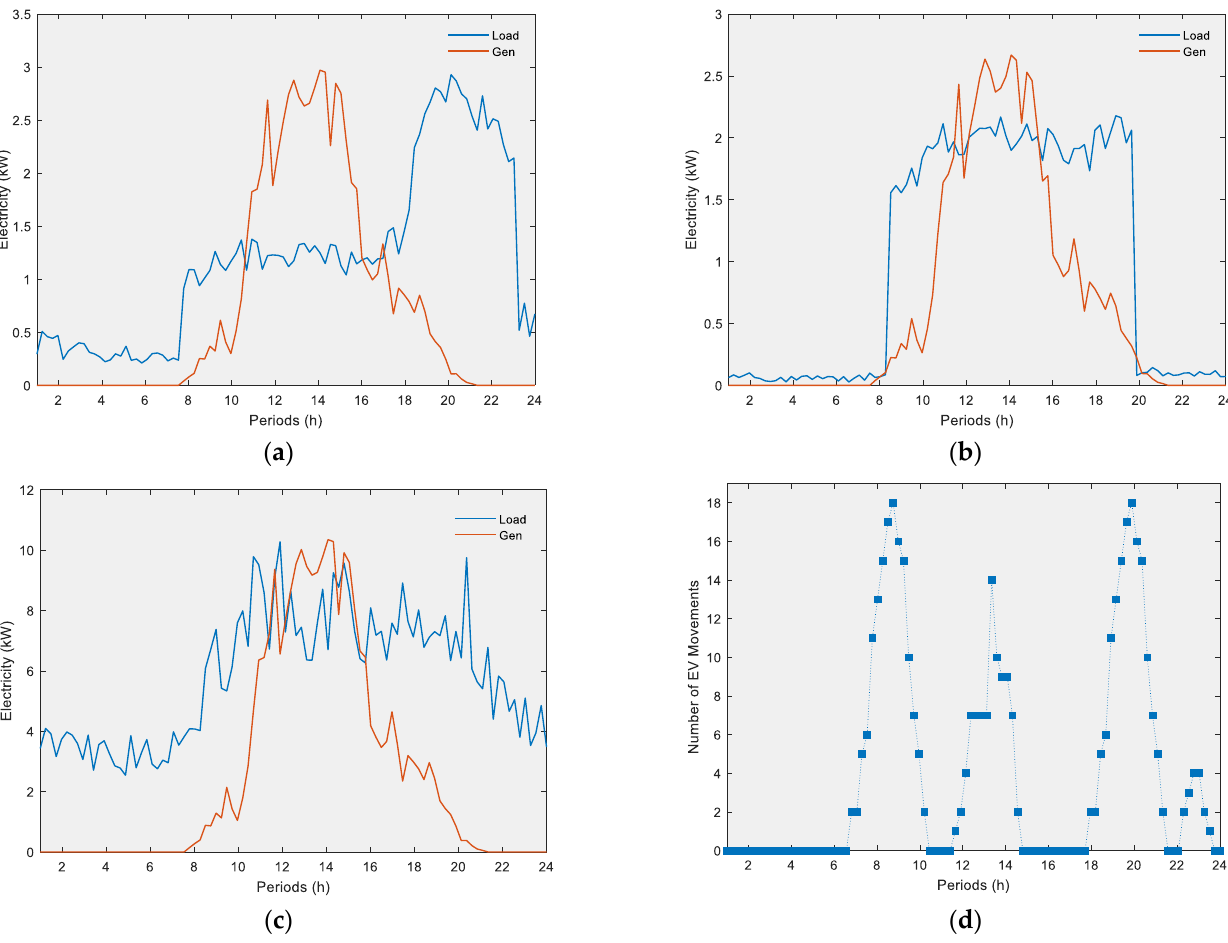
Figure 2. Case study profiles: ( a ) Households, ( b ) commercial, ( c ) industrial and ( d ) EV movements.